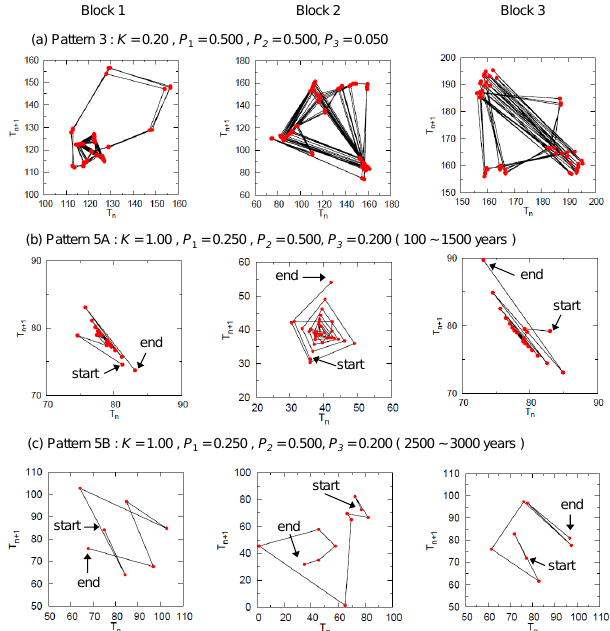
Figure 15. Iteration maps of recurrence intervals T n + 1 versus T n for (a) pattern 3, (b) pattern 5A, and (c) pattern 5B. The start and end points of maps (b) and (c) are indicated by arrows.